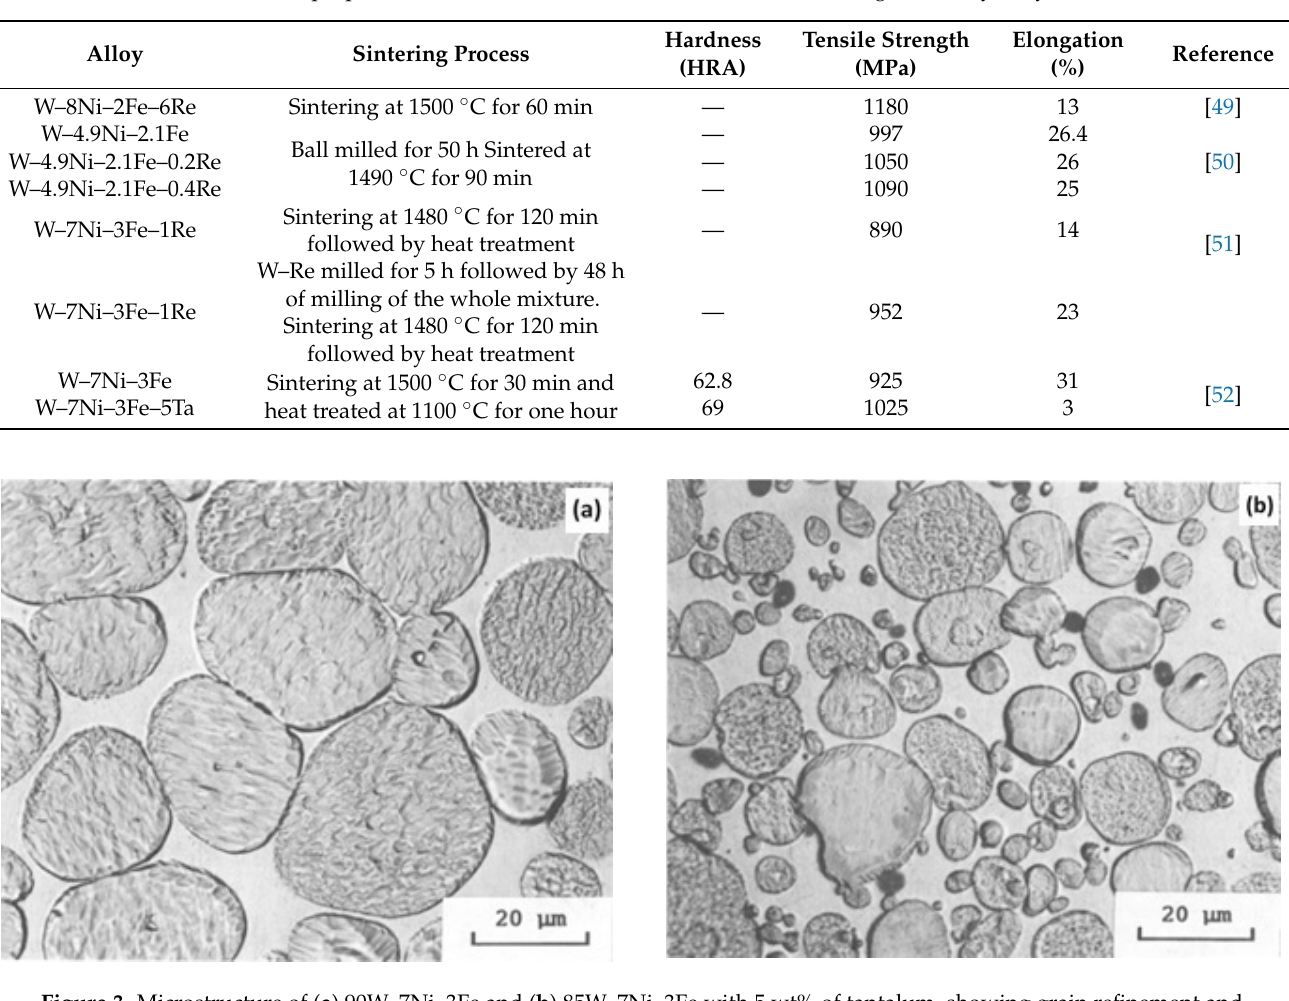
Table 1. Microstructural parameters of the Re added to the tungsten heavy alloy [51].